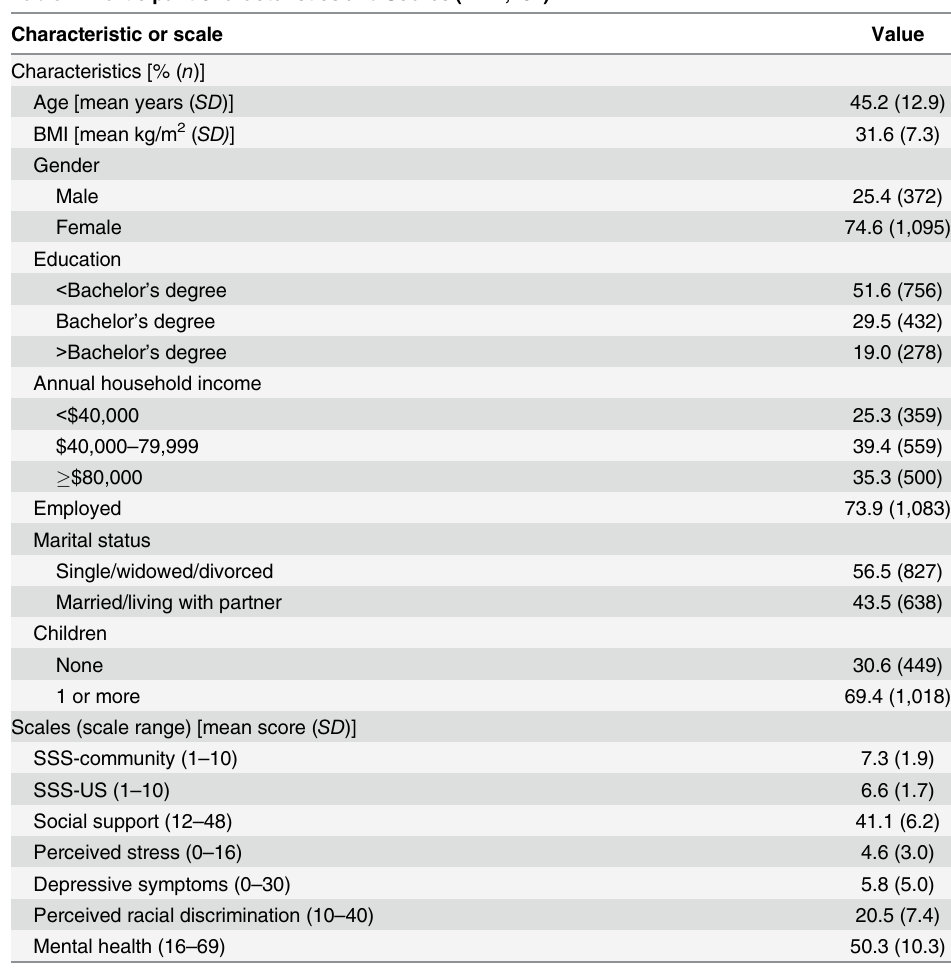
Table 1. Participant Characteristics and Scores ( n =